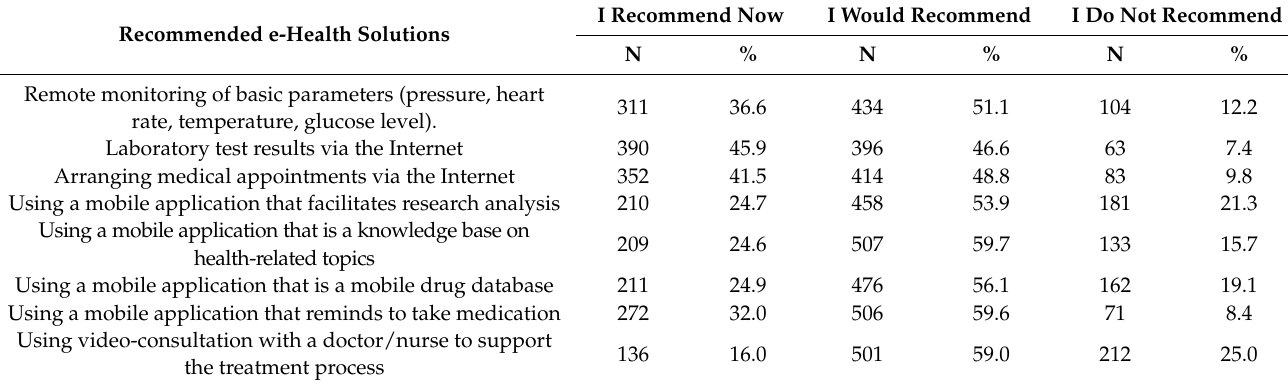
Table 4. Types of e-health solutions recommended by nurses.